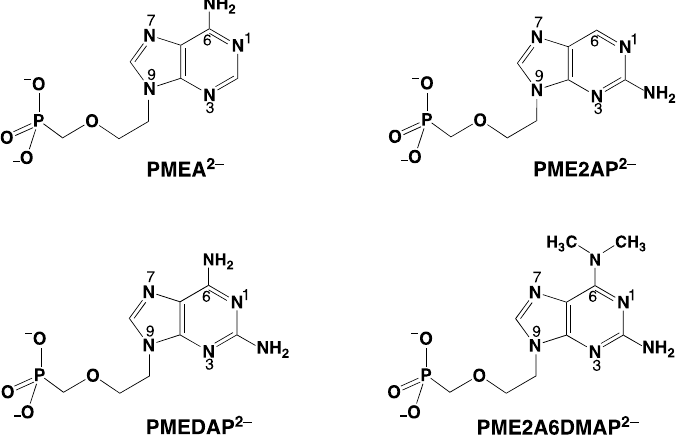
Figure 5. Chemical structures of the dianions of 9-[2-(phosphonomethoxy)ethyl]adenine (PMEA 2 − ), 9-[2-(phosphonomethoxy)ethyl]-2-aminopurine (PME2AP 2 − ), 9-[2-(phosphonomethoxy)ethyl]-2,6- diaminopurine (PMEDAP 2 − ), and 9-[2-(phosphonomethoxy)ethyl]-2-amino-6-dimethylaminopurine (PME2A6DMAP 2 − ). These compounds are abbreviated as PE 2 − . For the solution structure of PMEA 2 − , see legend of Figure 3. Replacement of the adenine residue in PMEA 2 − by a cytosine residue (Figure 1) gives PMEC 2 − = 1-[2-(phosphonomethoxy)ethyl]cytosine.